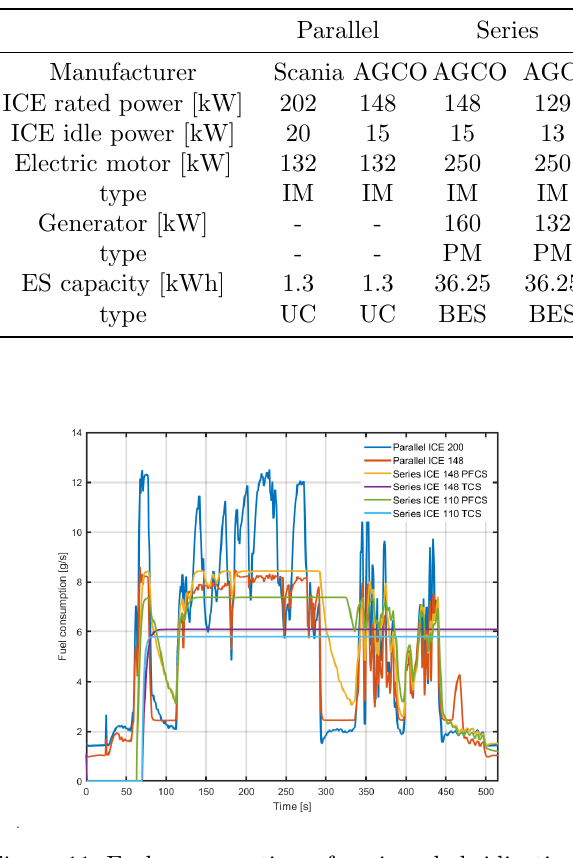
Figure 11: Fuel consumption of various hybridization options of the backhoe loader